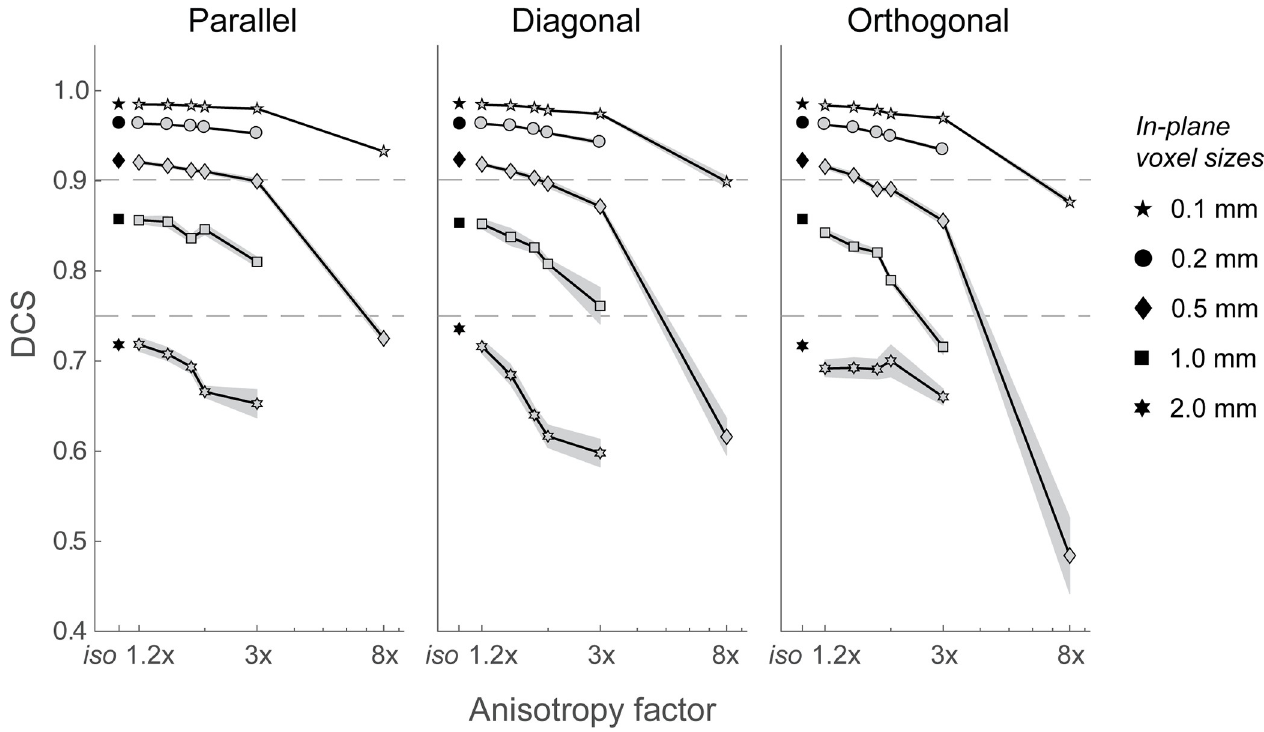
Fig 7. Similarity between volumes rated by the joint rater and the high-res (0.1mm) reference volume rated by the optimal rater. A DCS of 0.75 is considered the lower end of acceptable values [38]. DCS > 0.90 are considered ideal. Different marker symbols refer to the mean DCS for the different in-plane voxel sizes (0.1, 0.2, 0.5, 1.0 and 2.0mm). Isotropic voxel-size have a (rounded) relative volume of respectively 0.0006%, 0.005%, 0.08%, 0.6%, 5% of the ground truth ellipsoid volume (~165.0mm 3 ). The grey area represents standard deviations from the mean. Note that the standard deviations increases for the most anisotropic resolutions due to the increasing PVE for ellipsoids with large voxel sizes and increasing anisotropy. For visualisation purposes, anisotropy factors (x-axis) are plotted on a logarithmic scale. Dashed lines indicate the 0.75 and 0.90 DCS values.